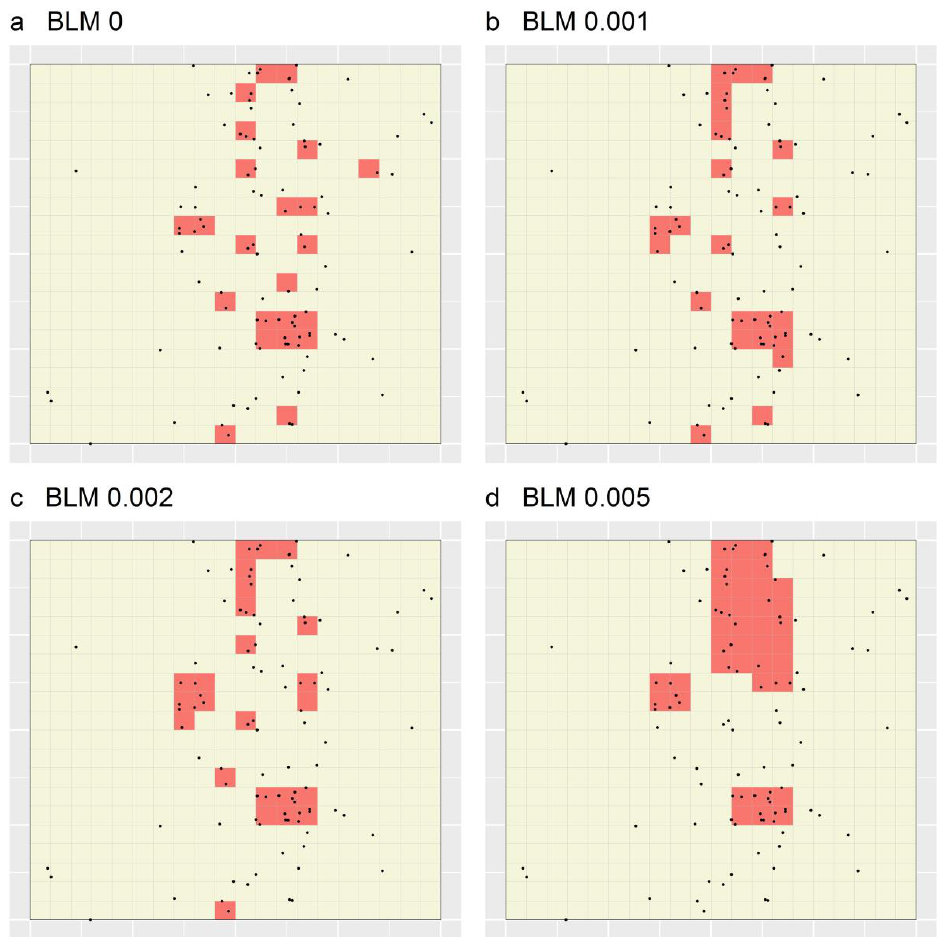
Figure 5. Optimal portfolios produced through applying Marxan to a simulated dataset while varying the specified BLM. Black dots depict the locations of the simulated cases, grid lines represent the set of spatial planning units specified for Marxan and the red-shaded regions represent the PAs delineated using